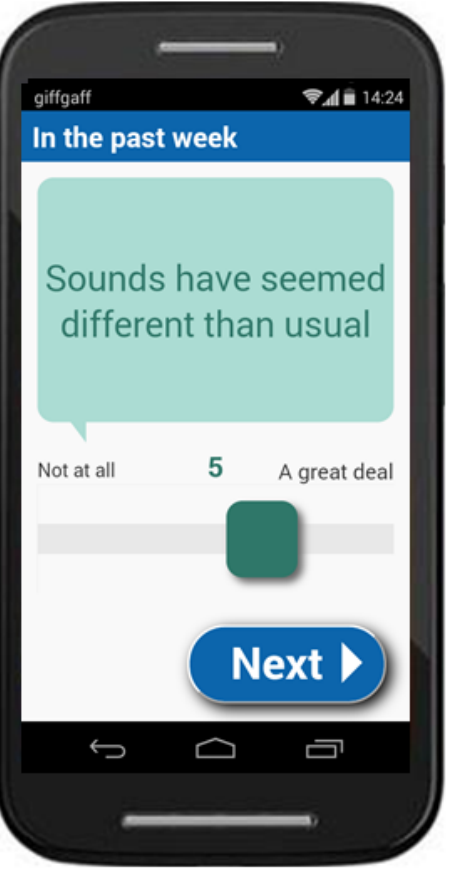
Figure 2. Screenshots of an example basic symptom item (left) and early signs item (right) displayed on the ExPRESS (Experiences of Psychosis Relapse: Early Subjective Signs)